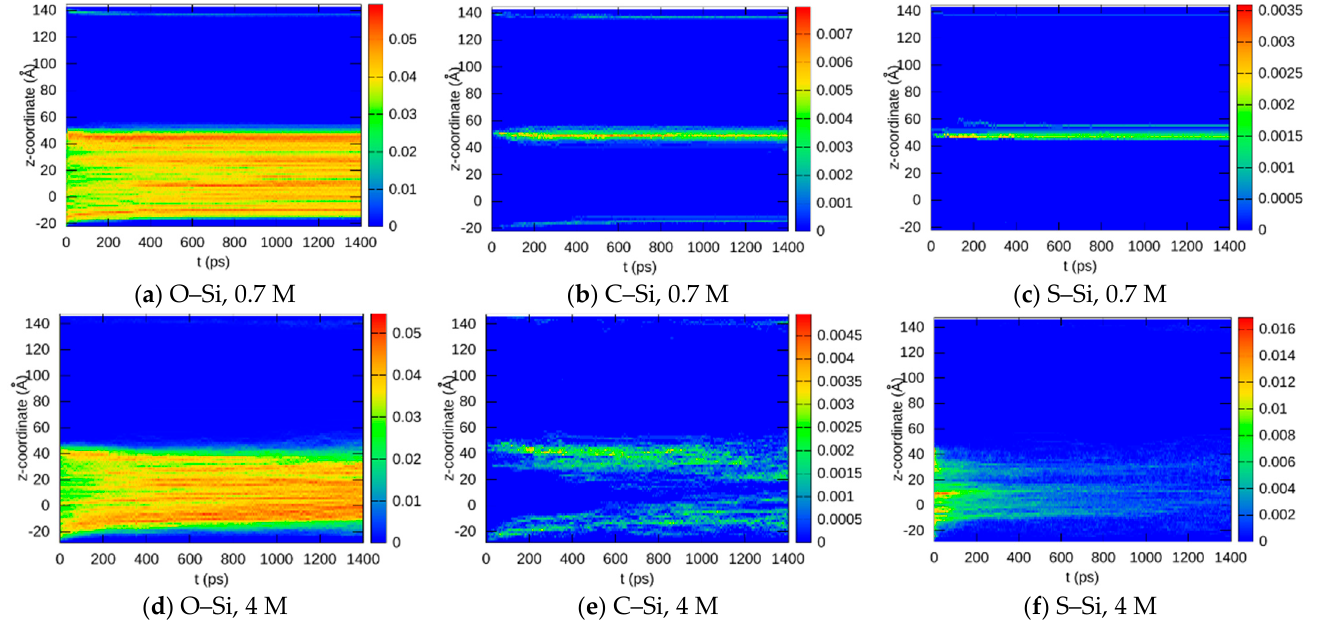
Figure 8. Space- and time-resolved densities of selected bond species during the ReaxFF dynamics of both simulated battery systems. Displayed are results for O–Si ( a ), C–Si ( b ) and S–Si ( c ) with 0.7 M LiTFSI and O–Si ( d ), C–Si ( e ) and S–Si ( f ) with 4 M LiTFSI.